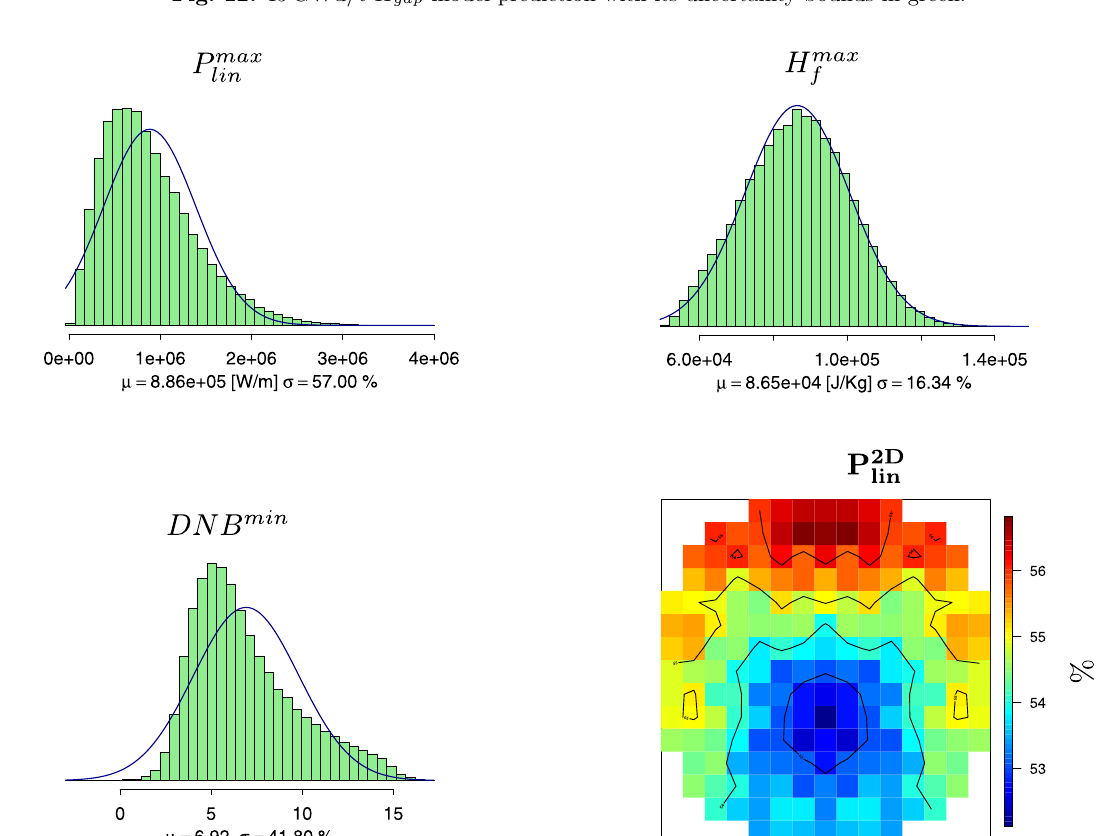
Fig. 13. P max , H max and DNB min histograms and P 2 D lin f